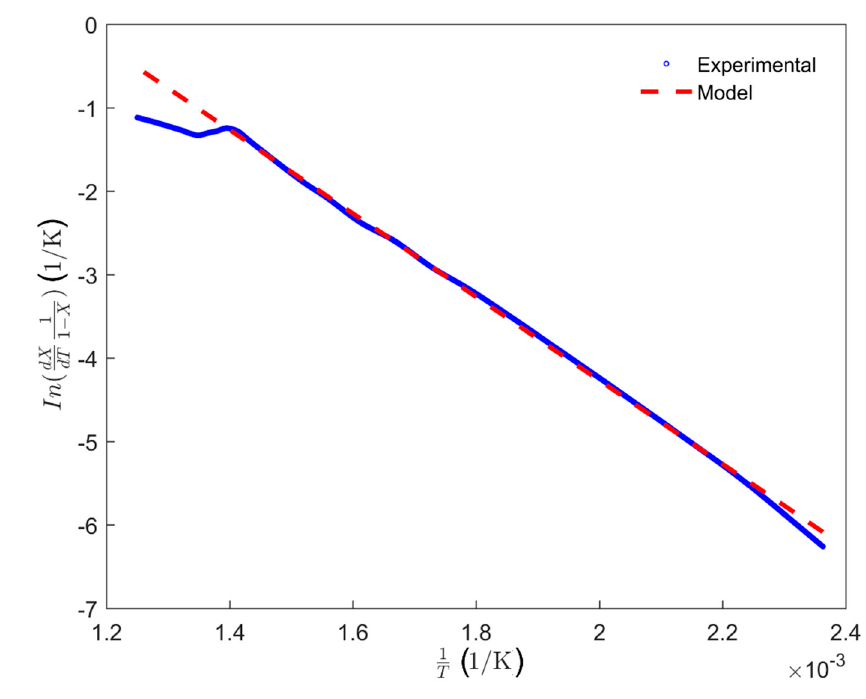
(cid:16) (cid:17) dX 1 as a function of 1 in determining T 1 − X dT in de- T